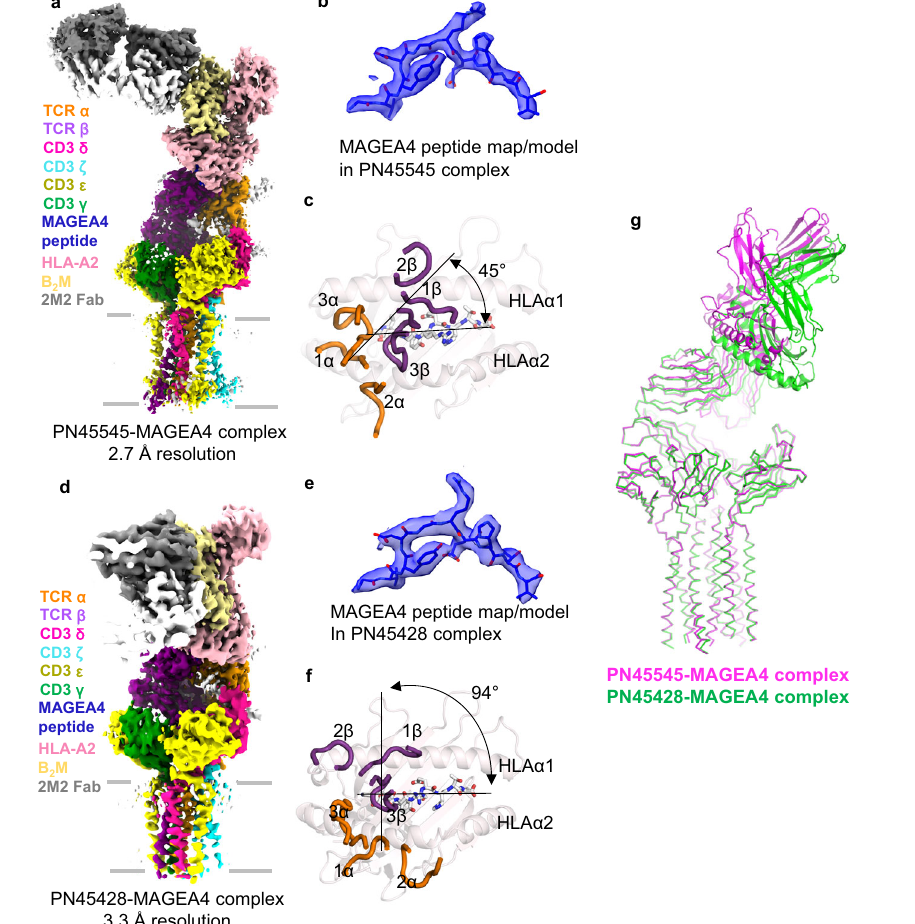
Fig. 2 | CryoEM structures of TCR-CD3 complexes with MAGEA4 pMHC. a cryoEMmapofPN45545TCR-CD3complexwithMAGEA4pMHC. b fi tofMAGEA4 peptideintothemapofthePN45545complex. c ,top-downviewofMAGEA4pMHC with α (orange) and β (purple)CDRs of PN45545 shown asloops. TCR interdomain vector and MHC groove vector are depicted as thin lines. The TCR docking angle reported by TCR3d database is shown. d cryoEM map of PN45428 TCR-CD3